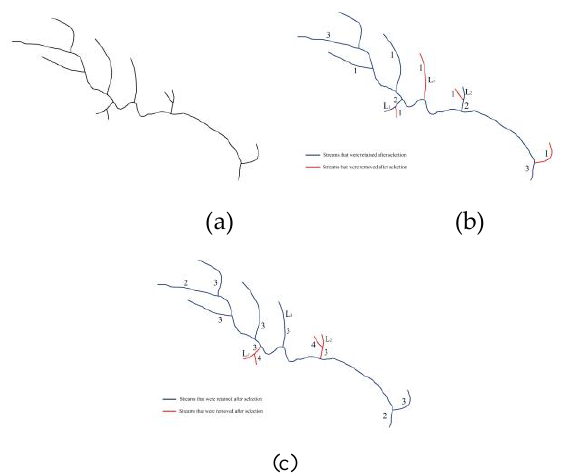
Figure 8. Comparison of stream selections for a topologically shallow substream with uniformly distributed tributaries: (a) original map, (b) selections based on Horton’s coding system and (c) selections based on our coding system